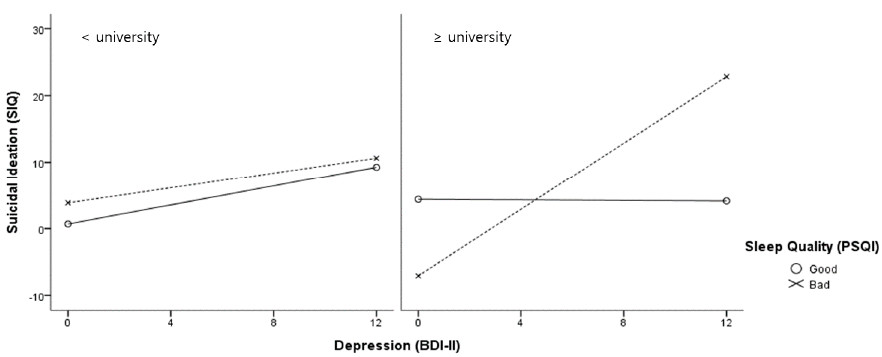
Figure 2. Slope test for the moderation effect of the sleep quality and education level.